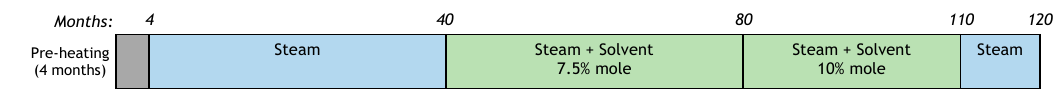
Figure 17. Combination of cycle’s duration and mole fraction that led to the same amount of oil production with a lower cEOR.